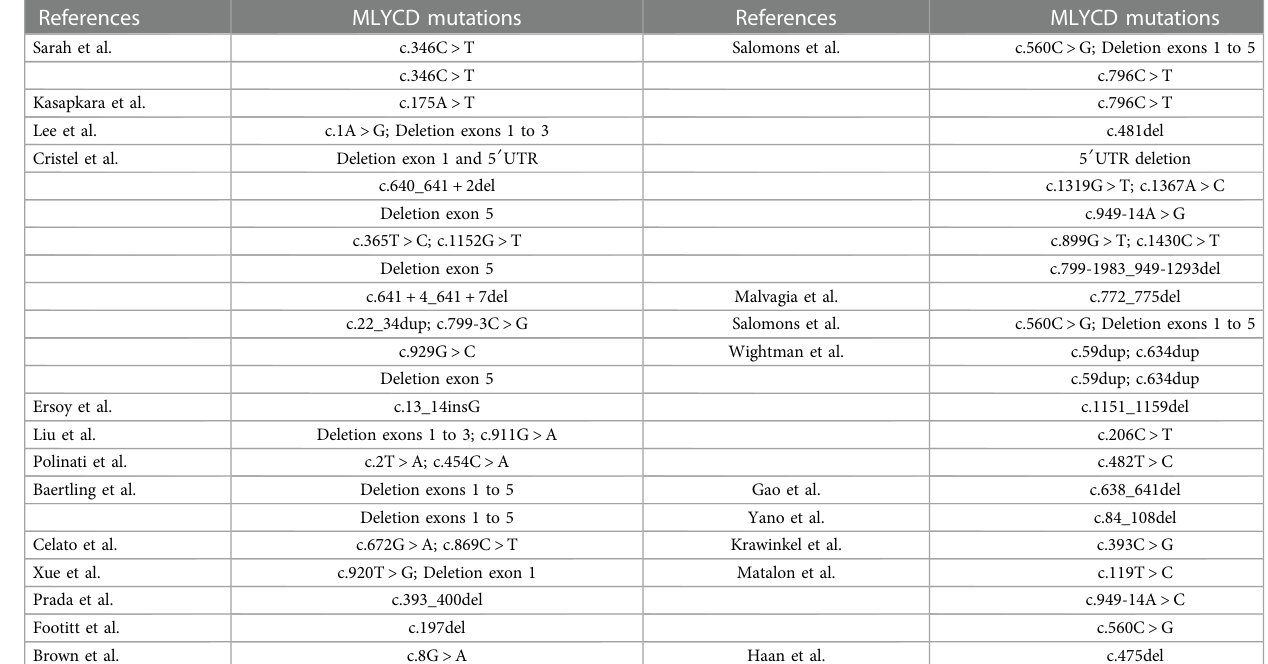
TABLE 3 Conditions of pathogenic genes in children affected with